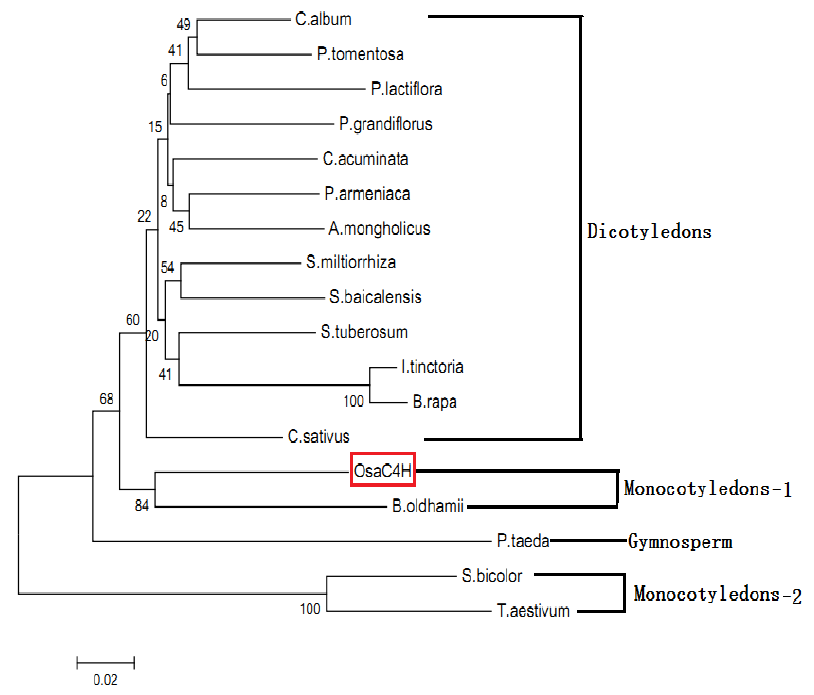
Figure 4. Phylogenetic tree illustrating the evolutionary relationships between OsaC4H and other C4Hs reported in C. album ( Canarium album , ACR10242), P. lactiflora (